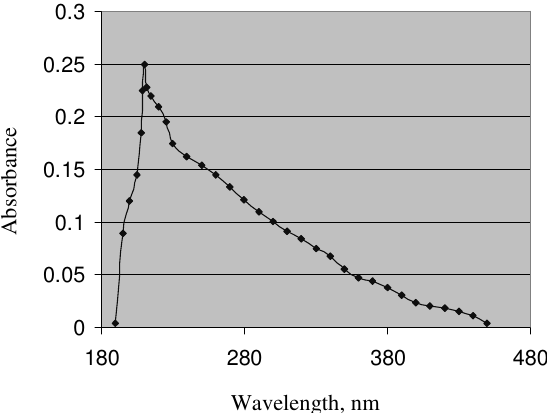
Figure 2. Absorption spectra of gabapentin (2.5